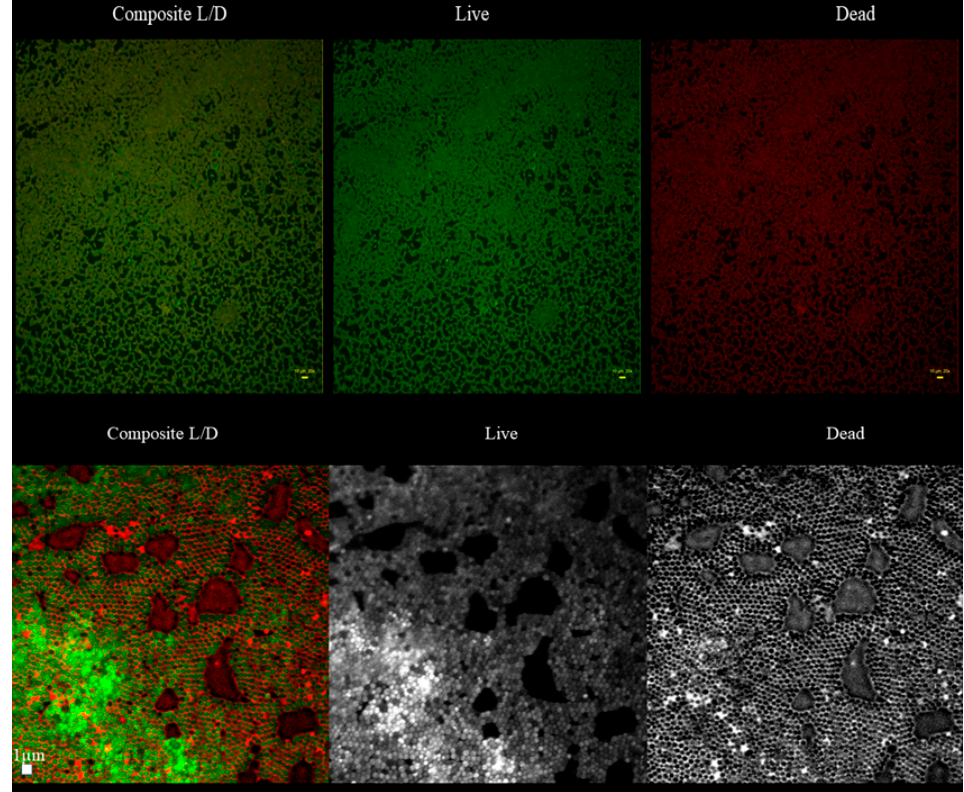
Figure 4. The presence of black non-fluorescent areas (“holes”) in the biofilm of the S1 strain. The upper part of the figure shows holes in the area magnified 20× (the upper panel consists of a composite image (L/D) and split channels (“live”—middle picture; “dead”—right picture). The bar size is 20µm. The “holes” are non-fluorescent (black areas) in any channel in this magnification. In turn in the 100x magnification (lower panel), “holes” take forms of non-fluorescent or red-fluorescent areas. Bar size is 1µm. For higher visibility, in the lower panel, the dye distribution (color fluorescence) was presented in the grey (from white to black) spectrum of colors. Upper panel: microscope LumaScope 600, magnification 20× (the bars show size of 10 µm); Lower panel: Microscope Cell Observer, magnification 100×.